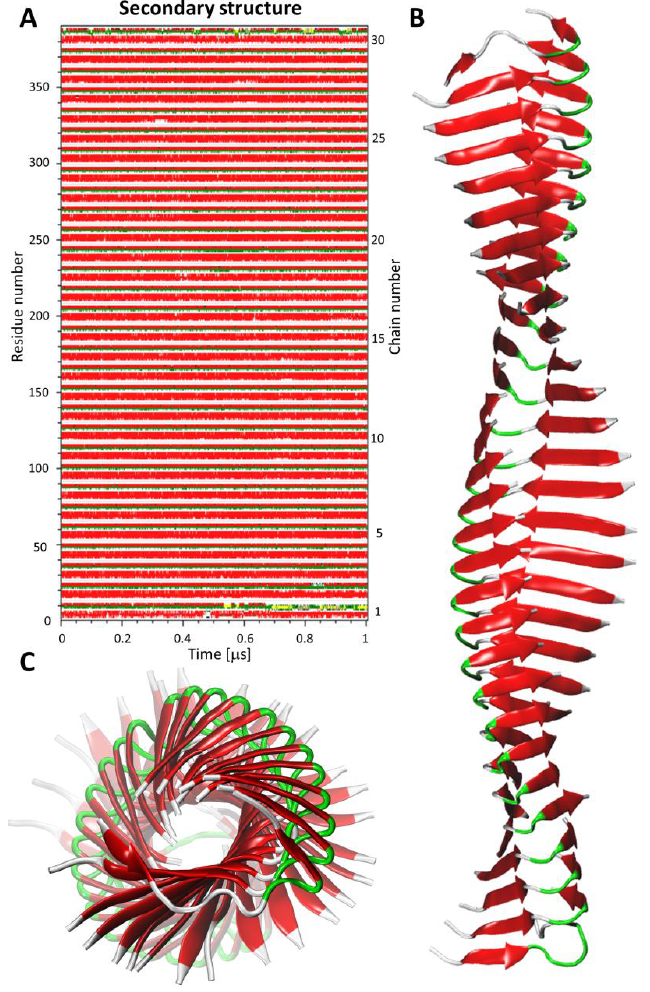
Figure 5. Secondary structure evolution plot calculated for the model of the amyloid fibril (M1_SIM1) during 1 µ s AA MD simulation—panel ( A ). Snapshot of the simulated amyloid fibril model in a cartoon representation: side view—panel ( B ), and view along fibril long axis—panel ( C ). Secondary structure assignment was carried out using DSSP software [44]. The following coloring scheme was used: coil—white, β -sheet—red, β -bridge—black, turn—green, bend—yellow, α -helix—blue, 3 10